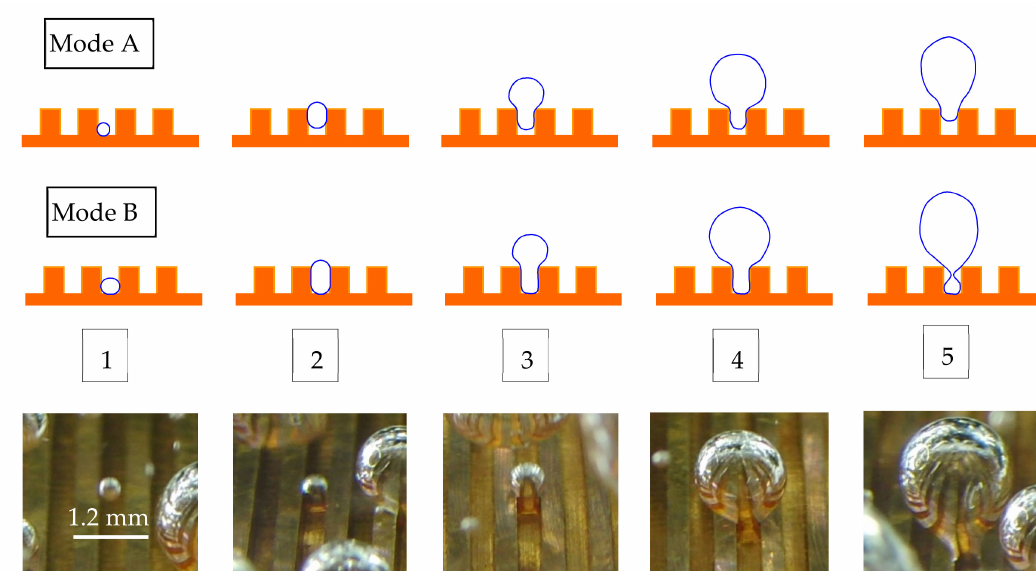
Figure 14. Bubble formation cycle in the microchannel of Specimen MC-0.4-0.4-0.8, q = 90 kW/m 2 : ( 1 ) bubble at the channel bottom; ( 2 ) bubble growing in the microchannel space; ( 3 ) forming the bubble above the microfin tips; ( 4 ) the beginning of the detachment period; ( 5 ) bubble